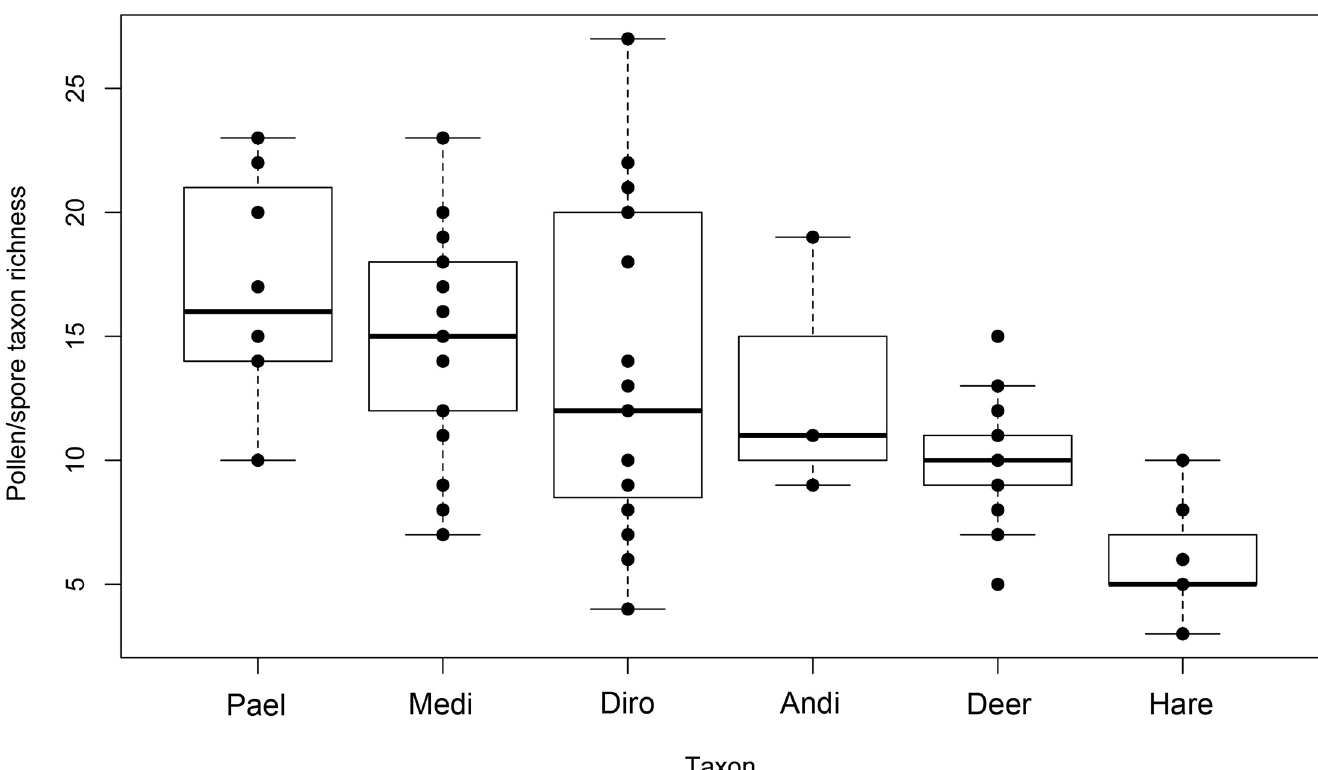
Fig 2. Richness of plant pollen and spore assemblages. Moa coprolites (Pael, Pachyornis elephantopus ; Medi, Megalapteryx didinus ; Diro, Dinornis robustus ; Andi, Anomalopteryx didiformis ) and deer and hare pellets from Daley’s Flat rock avalanche deposit.